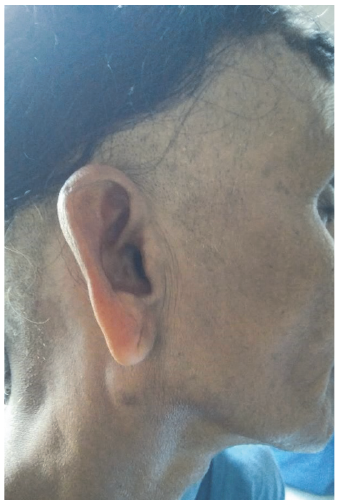
Figure 1: Figure showing right parotid swelling.